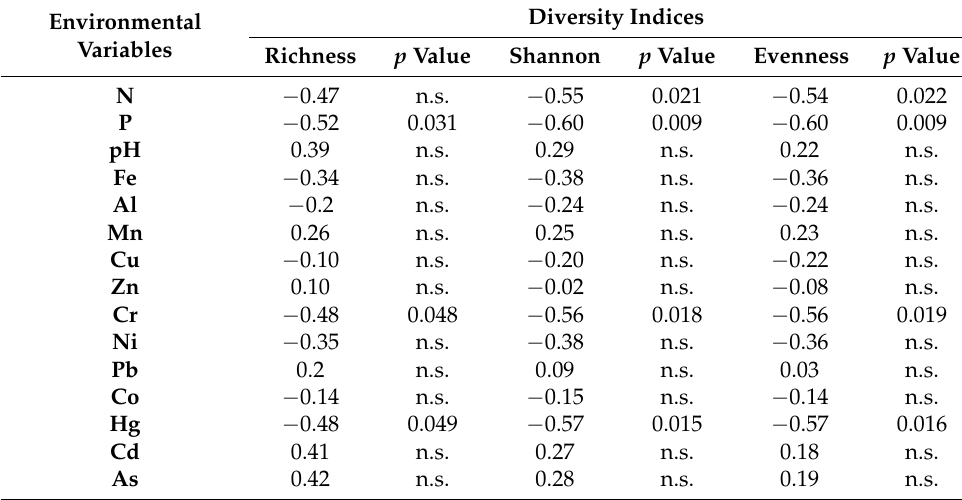
Table 4. Pearson correlation factors between alpha diversity (richness, Shannon and evenness) indices and the environmental variables (only correlation values with R > |0.5| and p -value < 0.05 were considered meaningful for the analysis, n.s. = not significant).